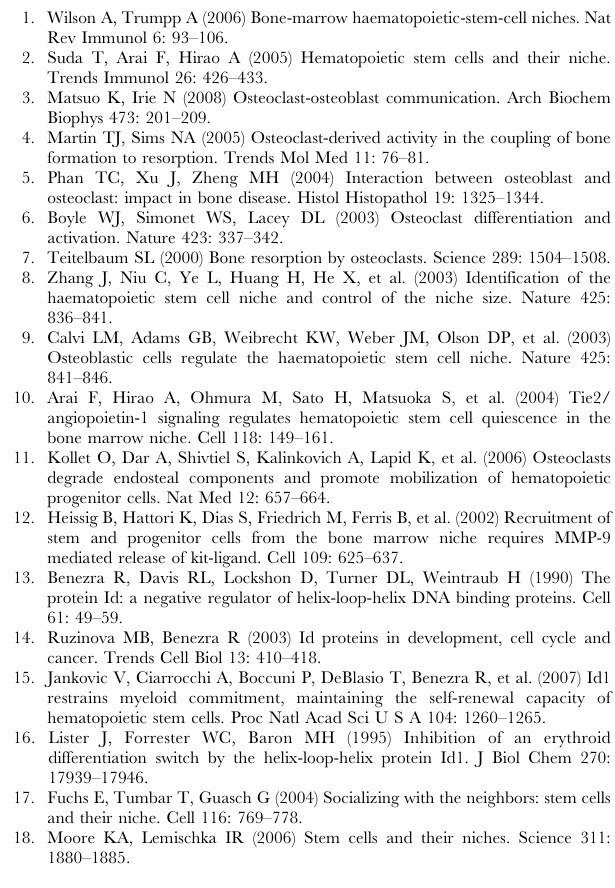
Figure S6 Use of lentiviral vectors for the overexpression of Id1.